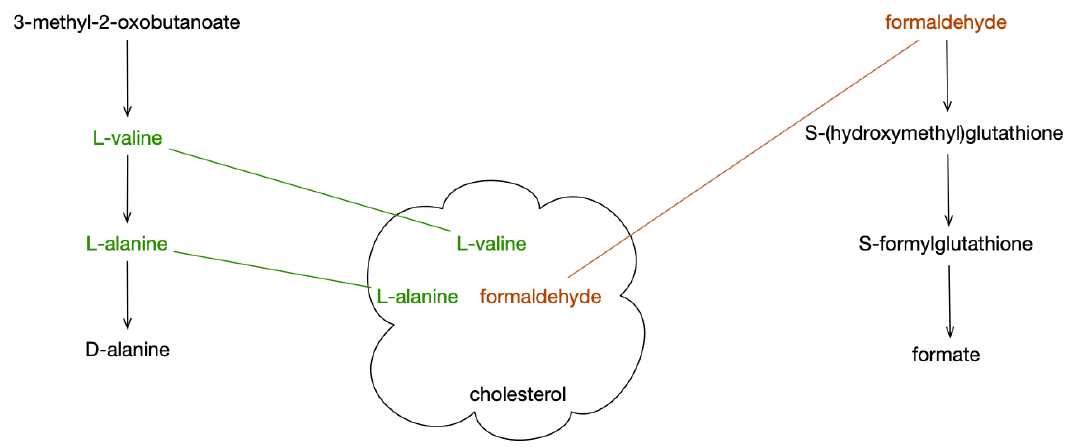
Figure 1. Schematic showing two pathways covering three compounds; the fourth compound has no pathways in the organism, and cannot be